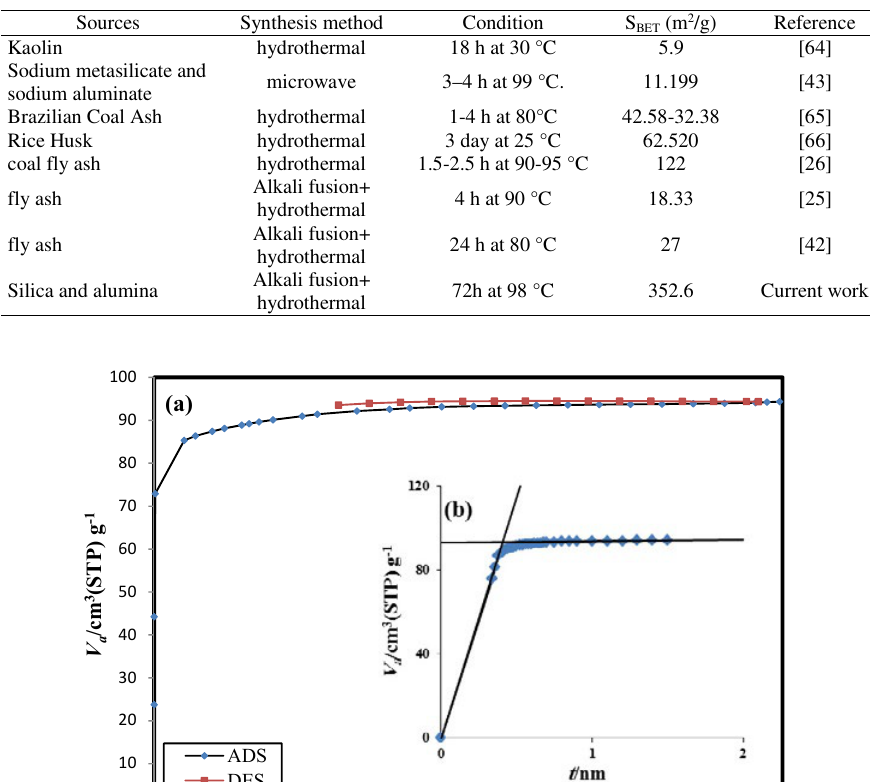
Table 3. Comparison between the specific surface areas of nano LTA zeolite with those reported in the literature.